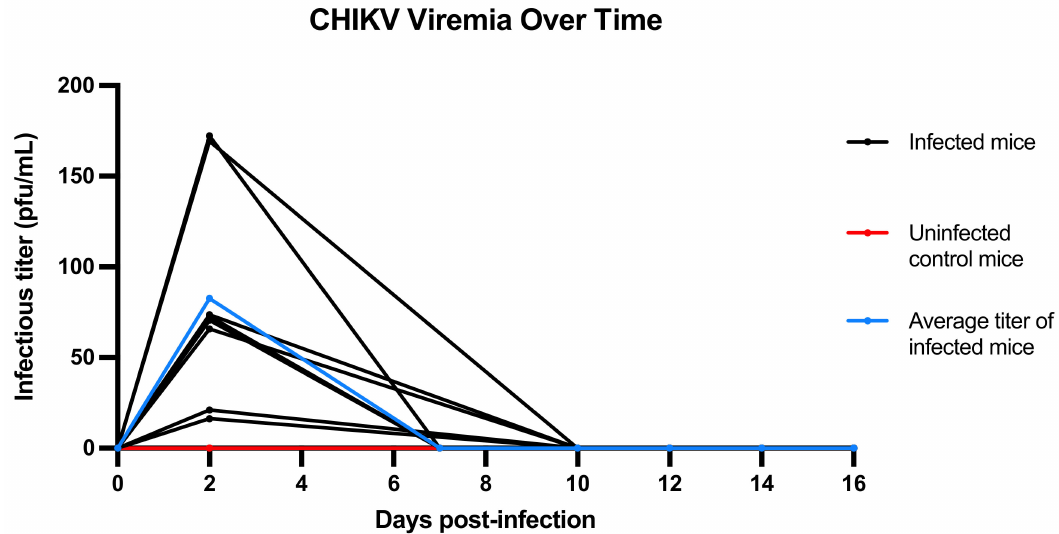
Figure 1. Chikungunya viremia in PFU/mL per mouse by days post infection (DPI). This graphical representation shows viremia in PFU/mL per infected mouse (black lines) and per uninfected control mice (red lines), as well as the average curve for infected mice (blue